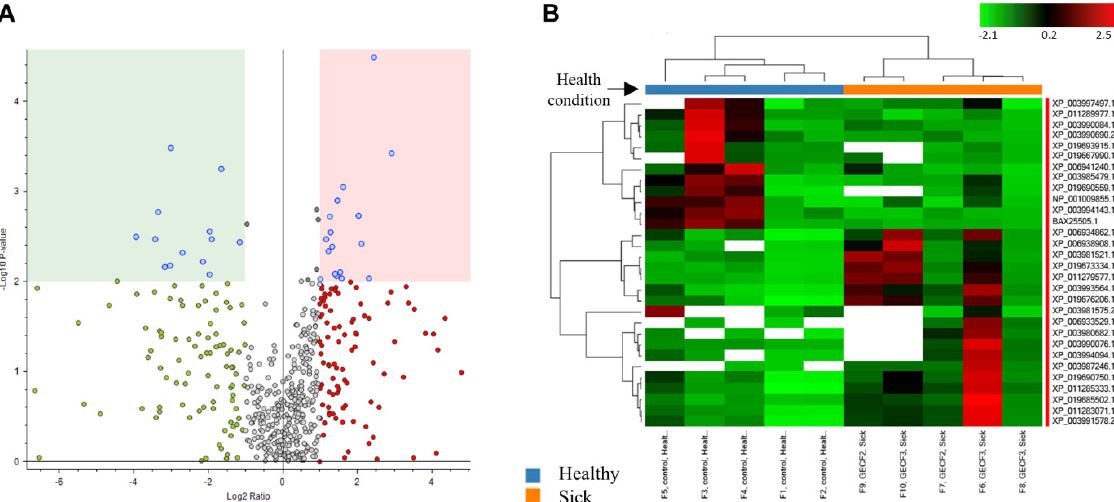
Figure 3. Deregulated proteins in FCGS patients. ( A ) Volcano plot representing the down-expressed and overexpressed protein abundance changes (green circles). Proteins were considered downregulated or upregulated if their fold-change values were <0.5 or >2, respectively, with a p -value < 0.01. ( B ) Heat map showing the protein levels exosomes isolated from FCGS cats (orange bar) versus healthy donors (blue bar).